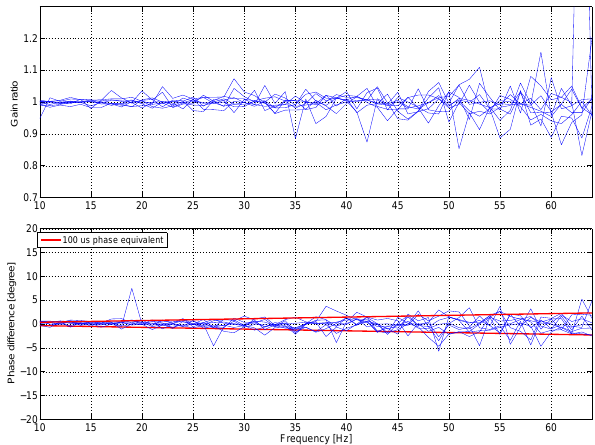
Figure 13. Comparison of gain and phase for MMS 1 SCM and DFG